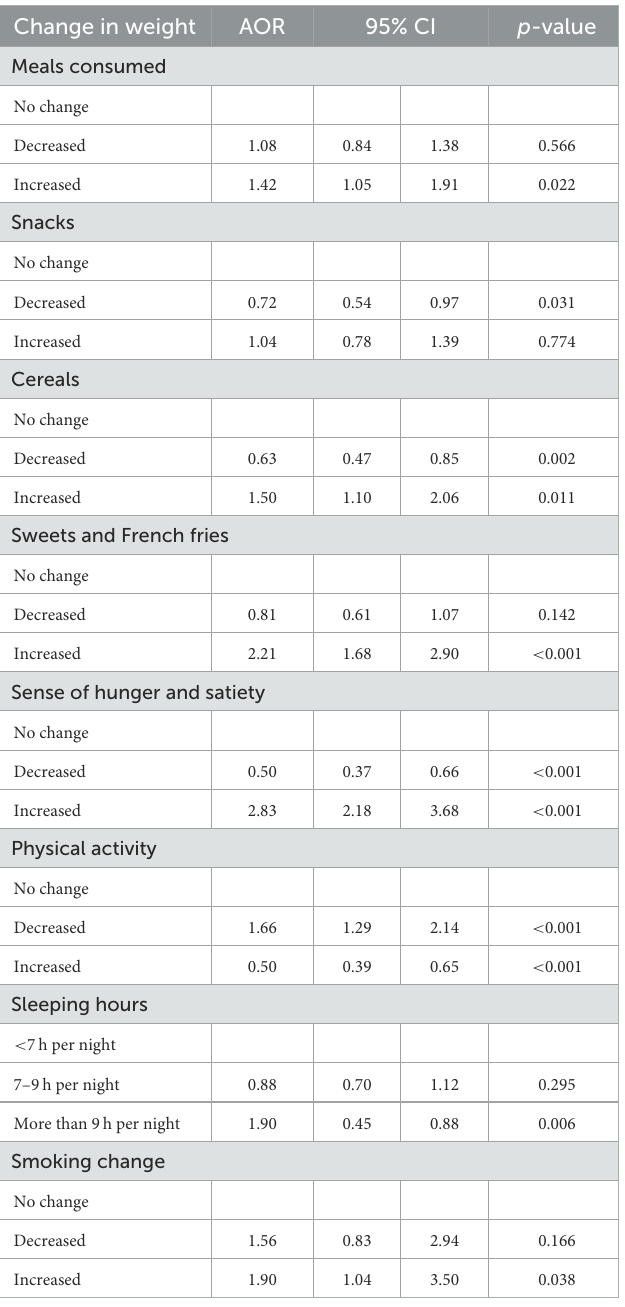
TABLE 5 Adjusted factors significantly associated with a change in